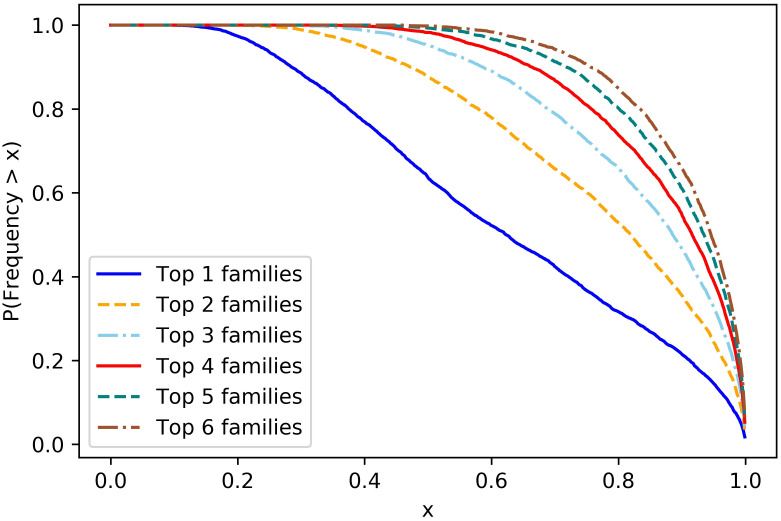
Distribution of 1A family sizes in the type 1 population.To better understand the distribution of 1A family sizes, we used the Poisson-Dirichlet(α, 0) distribution to generate the six largest families. The plot gives the probability that the number of individuals in the top i families are greater than a fraction x of the total type 1 population.